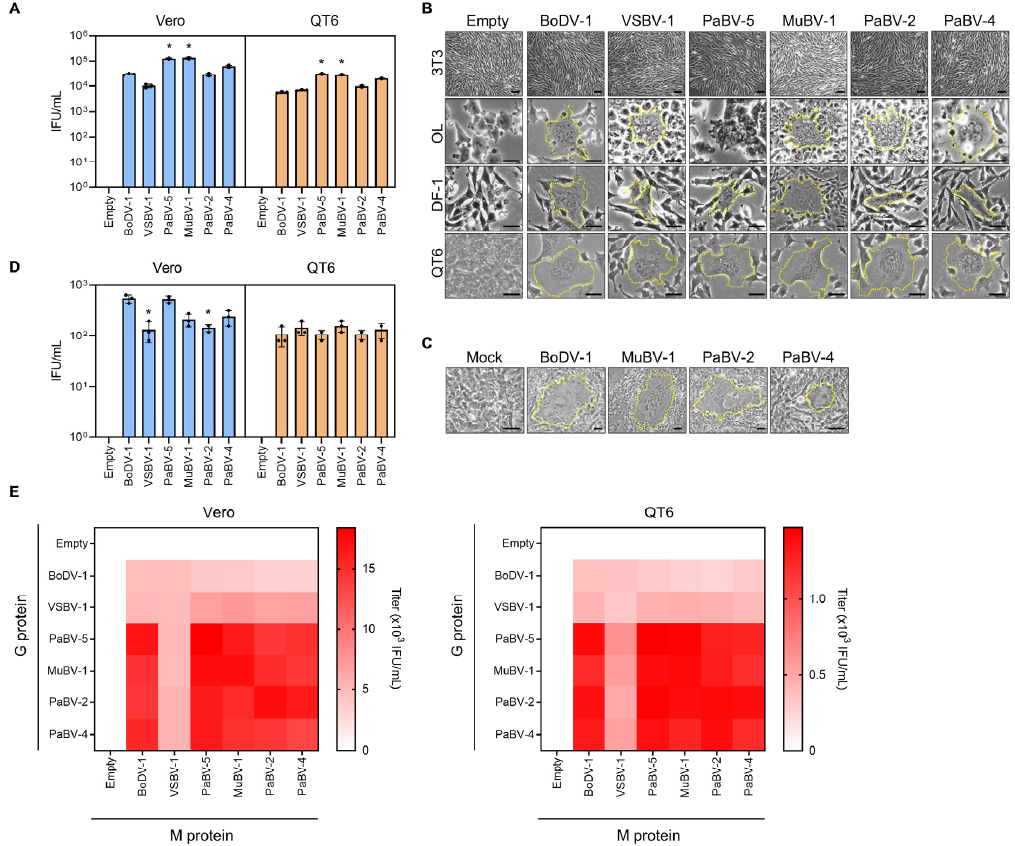
Figure 2. The host specificity of orthobornaviruses is not determined by the cell entry step. ( A ) Infectivity of G-pseudotyped recombinant BoDV-1 (rBoDV-1s) in Vero (blue) and QT6 cells (orange). Plasmids expressing the G protein from each genotype were transfected into 293T cells persistently infected with rBoDV Δ G GFP, and the produced G-pseudotyped BoDV-1s were inoculated into the cell lines. GFP-positive cells were counted by fluorescence microscopy at 3 days post infection. ( B ) Orthobornavirus G protein-mediated syncytium formation. Cell lines expressing glycoprotein (G) from the indicated genotypes were treated with a pH 5.0 solution, and syncytium formation was induced. The area enclosed by the yellow dotted lines indicates syncytia. Bars, 30 μ m. ( C ) Syncytium formation of orthobornavirus-infected cells. QT6 cells infected with BoDV-1, PaBV-2, PaBV-4 and MuBV-1 were treated with a pH 5.0 solution, and syncytium formation was induced. Bars, 30 μ m. ( D ) Infectivity of M-pseudotyped rBoDV-1s in Vero (blue) and QT6 cells (orange). The method was the same as that used in the G protein pseudotype assay. Plasmids expressing the matrix protein (M) from each genotype were transfected into 293T cells persistently infected with rBoDV Δ M GFP, and the produced viruses were inoculated into the cells. ( E ) Infectivity of MG-pseudotyped rBoDV-1s. Each combination of M and G expression plasmids from the genotypes were transfected into 293T cells persistently infected with rBoDV Δ MG GFP, and the produced viruses were inoculated into Vero (left) and QT6 (right) cells. The X and Y axes show the M and G genotypes of transfected plasmids used for generating the pseudotype viruses, respectively. Infectivity titers of each pseudotyped rBoDV-1 are indicated by color. The titers corresponding to the heat map colors are indicated. All experiments were performed with 3 biologically independent replicates. The values are expressed as the means ± SEs. Significance was analyzed by one-way ANOVA and Dunnett’s multiple comparison test. *, p < 0.05.